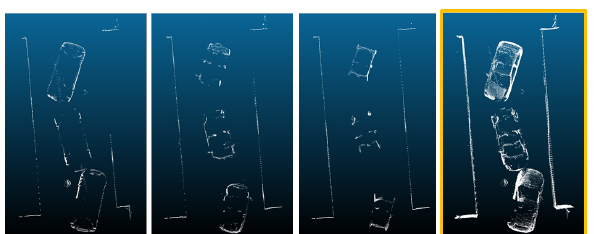
Figure 11. Sections of the point cloud inside the tunnel. On the right the 2D model obtained by overlapping several of them.